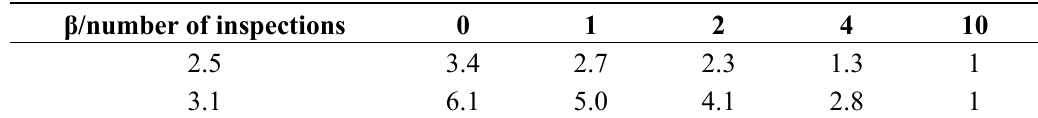
Table 18. Required FDF values for minimum cumulative reliability level. SN-curve: “With cathodic protection”. Inspections with the eddy current